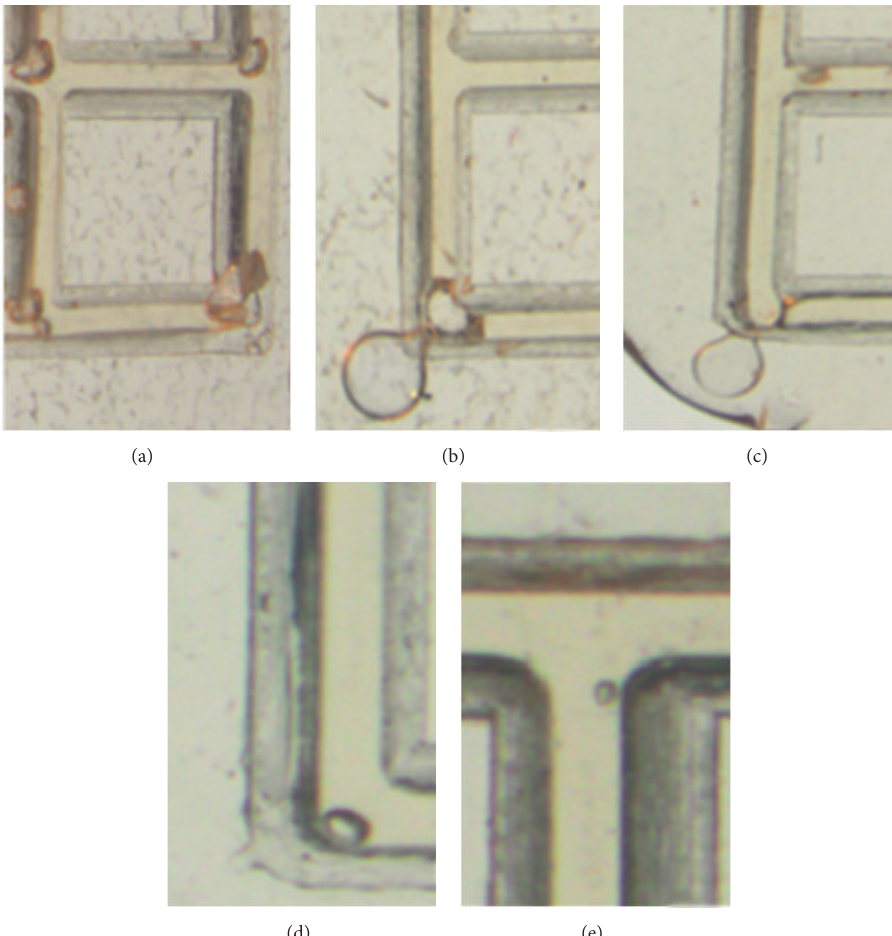
Figure 16: Bubbles’ formation rules (all the edges in the figures have the width of about 300 𝜇 m). (a) Microstructure deficiencies; (b), (c) escaping air; (d), (e) compressed small bubbles.